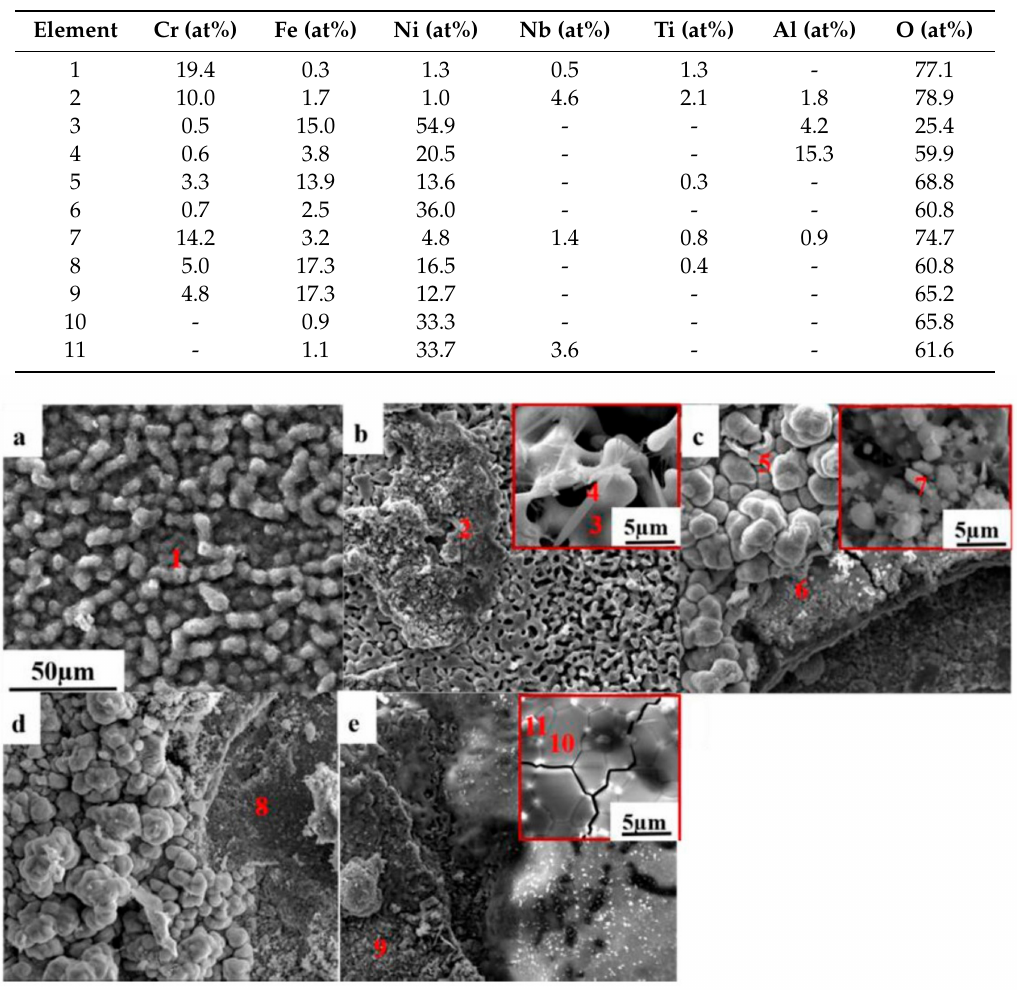
Table 2. The EDS results of points shown in Figure 5.